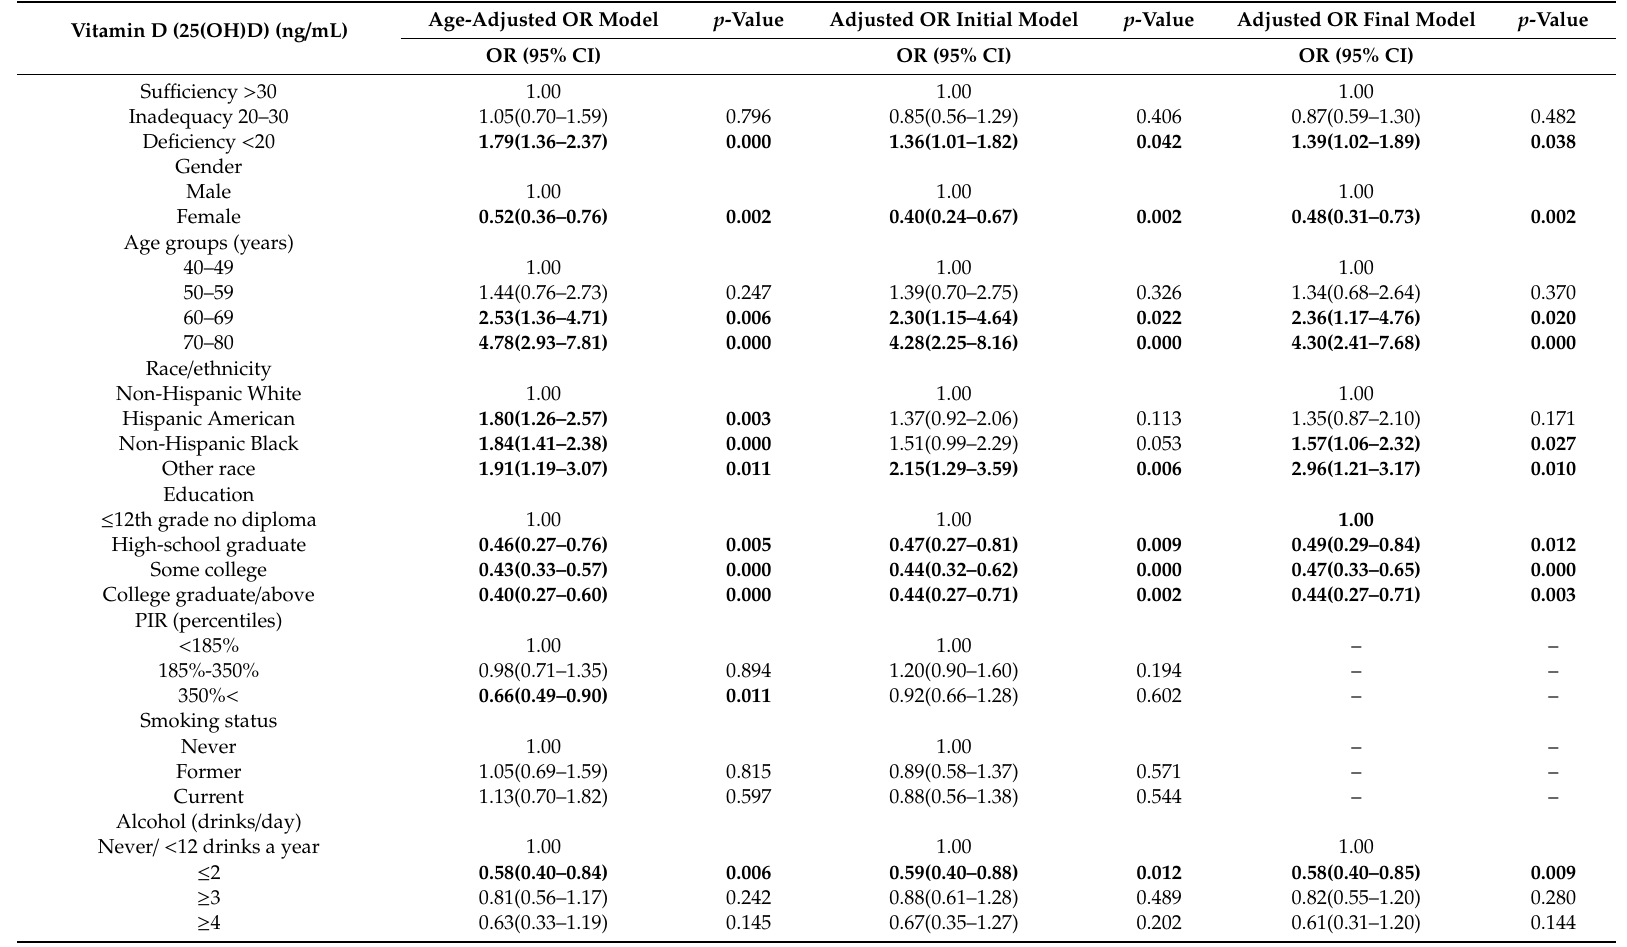
Table 2. Adjusted associations between Vitamin D (25(OH)D) and smell impairment in American adults aged 40–80 years ( n = 2216), the NHANES 2013–2014. Vitamin D (25(OH)D) (ng /